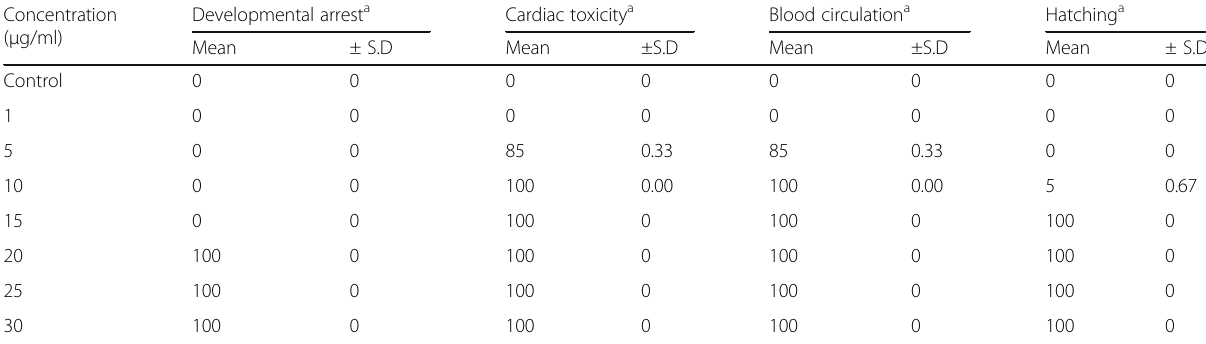
Table 2 Teratogenic dose response of zebrafish embryos exposed to crude seed extract of M. charantia at 72hpf Concentration Developmental arrest a Cardiac toxicity a Blood circulation a Hatching ( μ g/ml)